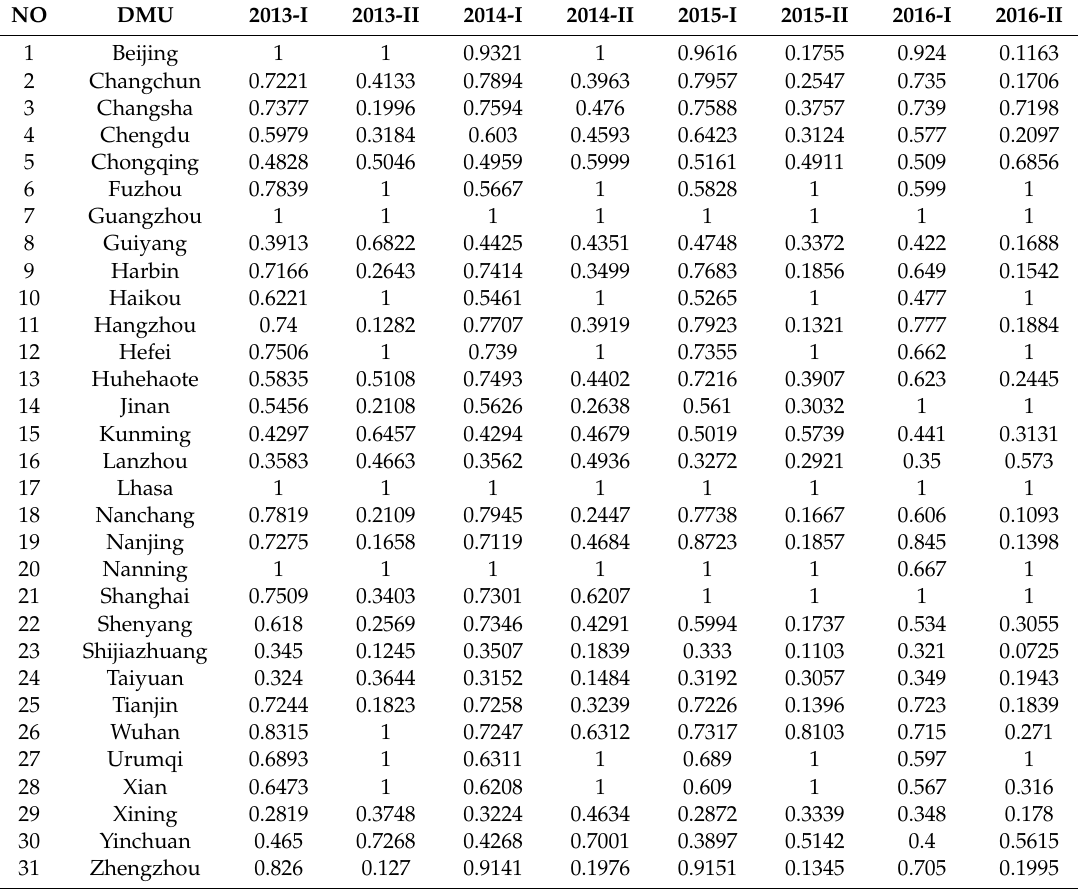
Table 4. Two stage e ffi ciencies by city from